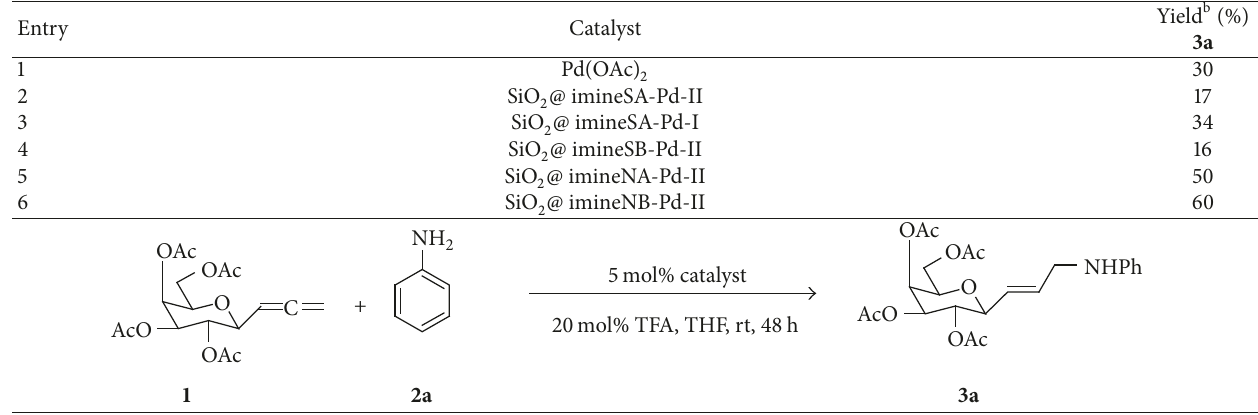
Table 2: Optimization of reaction conditions of C -(tetra- O -acetyl- 𝛽 -D-galactopyranosyl)allene (1) with aniline (2a) .